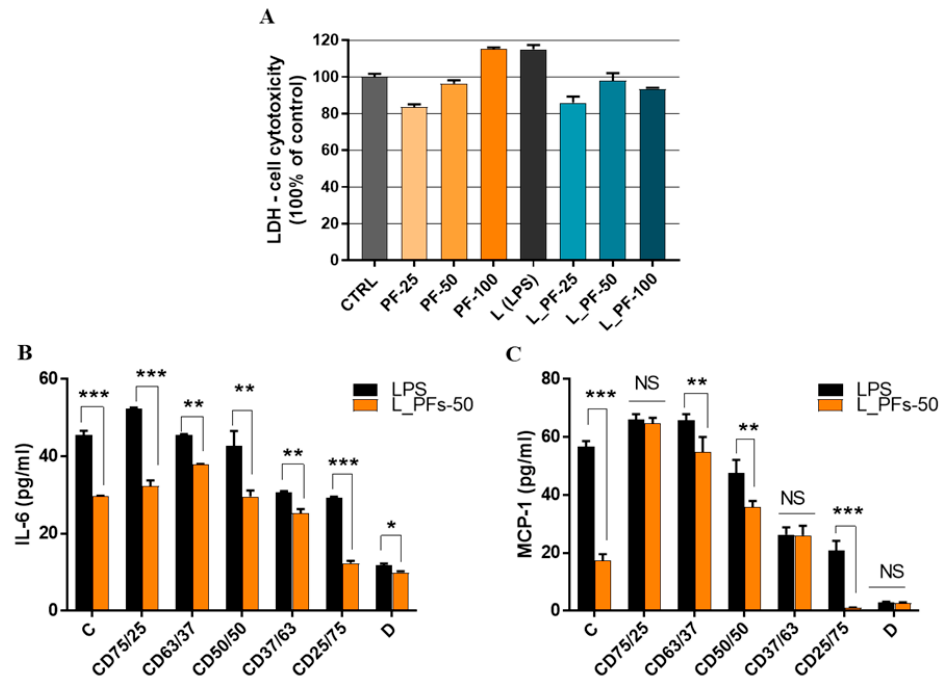
Figure 9. PFs-loaded hydrogels are biocompatible ( A ) and significantly reduce secretion of pro-inflammatory cytokines IL-6 and MCP-1 in human fibroblasts: ( A ) Quantitative evaluation of the cytotoxicity released by fibroblasts cultured on functionalized hydrogels, after 72 h of culture, using LDH assay; ( B , C ) IL-6 and MCP-1 concentration released in condition media from cells grown on PFs-hydrogels tested with ELISA assay. Data are presented as a mean ± SD ( n =3). An unpaired t -test was performed with GraphPad Prism. * p ≤ 0.05, ** p ≤ 0.01, *** p ≤ 0.001, NS–nonsignificant.